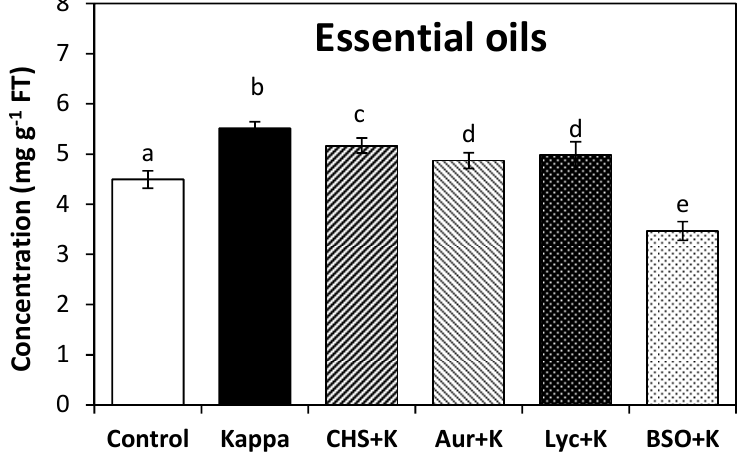
Figure 2. Level of total essential oils in leaves of Eucalyptus trees treated with water (control), with OC kappa at 1 mg·mL − 1 , or with CHS-828 and OC kappa (CHS+K), auranofine and OC kappa (Aur+K), lycorine and OC kappa (Lyc+K) and buthionine sulfoximine and OC kappa (BSO+K) and cultivated for 4 months. The level of essential oils is expressed in milligrams per gram of fresh tissue (FT). Bars represent mean values of three independent experiments and letters significant differences ( p <